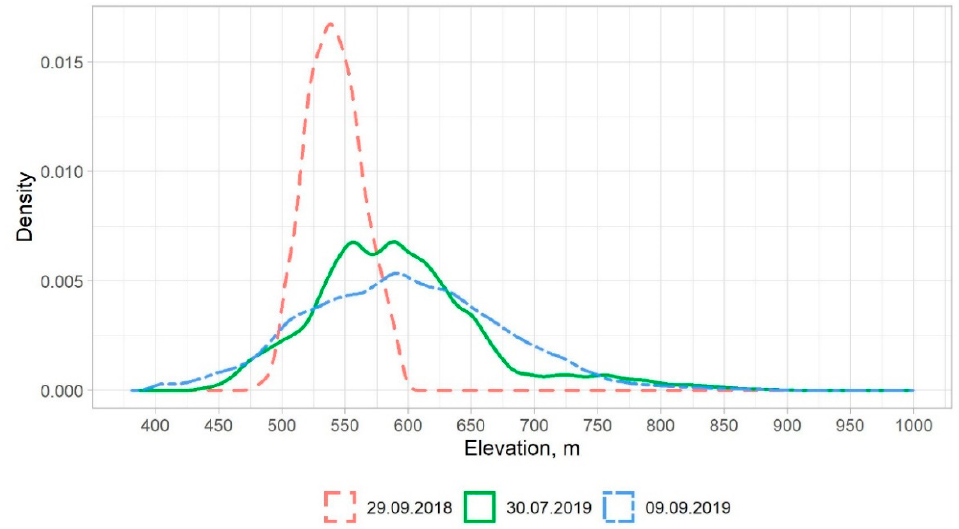
Figure 4. Spatiotemporal dynamics of the damaged plantings considering the height above sea level. The graph shows that the median values of the altitude of tree damage in 2018 were lower than in subsequent periods. The range of variation of damage depending on altitude increased over time. The distribution of random variables appears to be approximately normal. Table 3 gives descriptive statistics of the distributions. Table 3. Statistical indicators of the distribution of damaged forest stands by height above sea level.